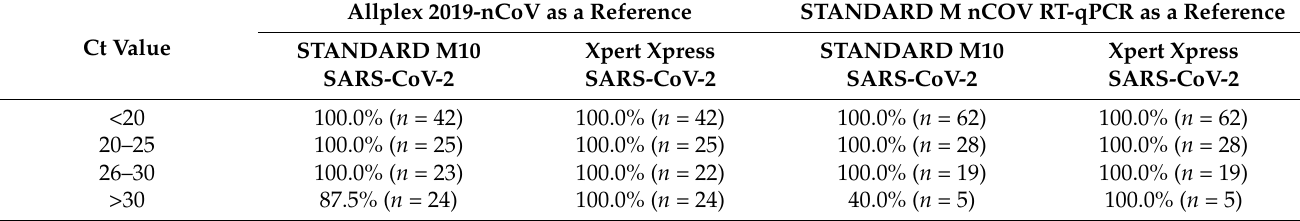
Table 2. Positive percent agreement of STANDARD M10 and Xpert Xpress depending on two RT-qPCR Ct values.